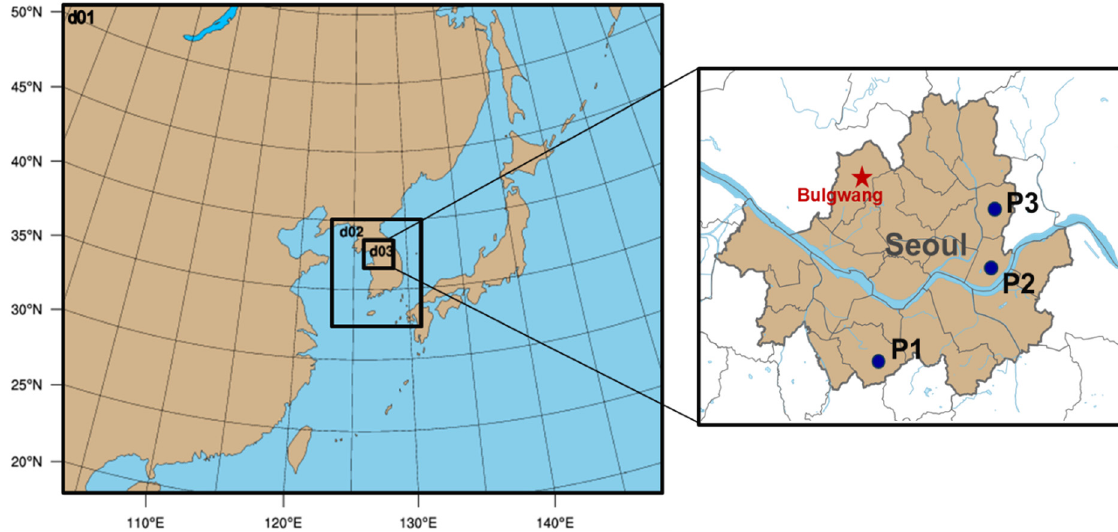
Figure 1. Three nested domains were implemented in the Weather Research and Forecasting regional air quality and chemistry model (WRF-Chem): D01 (grid spacing, 27 km; Northeast Asia), D02 (9 km; Korean Peninsula), and D03 (3 km; South Korea). Three planetary boundary layer height (PBLH) observation sites are shown: Gwanak (P1), Gwangjin (P2), and Jungnang (P3). An air quality measurement site (Bulgwang) is also shown.